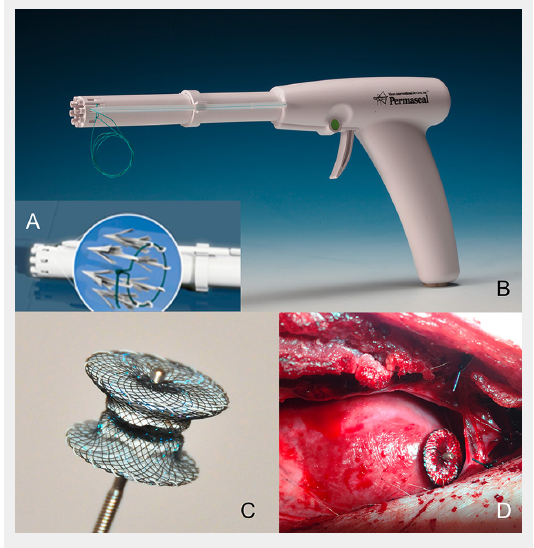
(A) The Permaseal TM device is made of eight polypropylene V-stays inserted in the left ventricular apex. (B) The gun-shaped Permaseal TM delivery system (Source: courtesy of Micro Interventional Devices). (C) The Safex TM is a self-expandable, self- anchoring and self-sealing flexible device. (D) Surgical view of the Safex TM